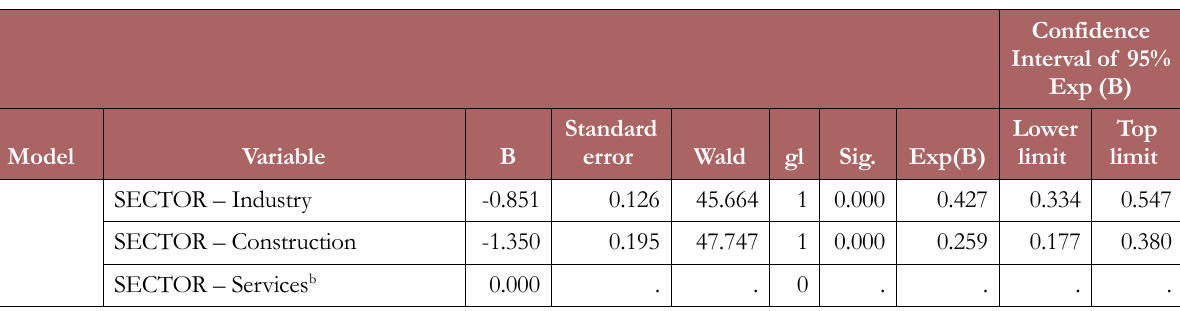
Table 7. Parameter estimates of model on e-business (Late Movers as reference category)